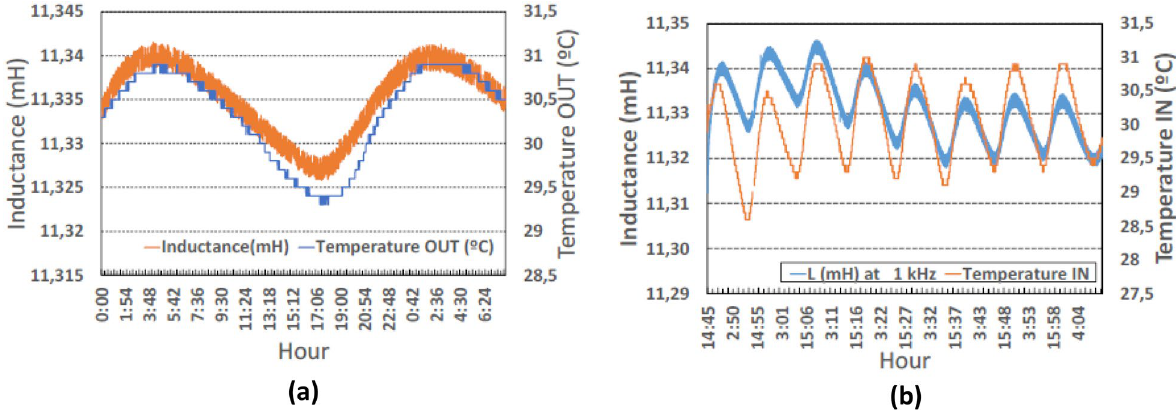
Figure. 2. Inductance measurements vs temperature. ( a ) Plot of the inductance outside the box (from 2020 November 3 to 11) along with temperature beside the coil. The inductance follows the temperature variations. Time span of about two days for better visualize the synchronism of inductance and temperature ( b ) plot of the inductance inside the box (from 27 Oct to Nov 3); as expected, inductance deviates from temperature variations.